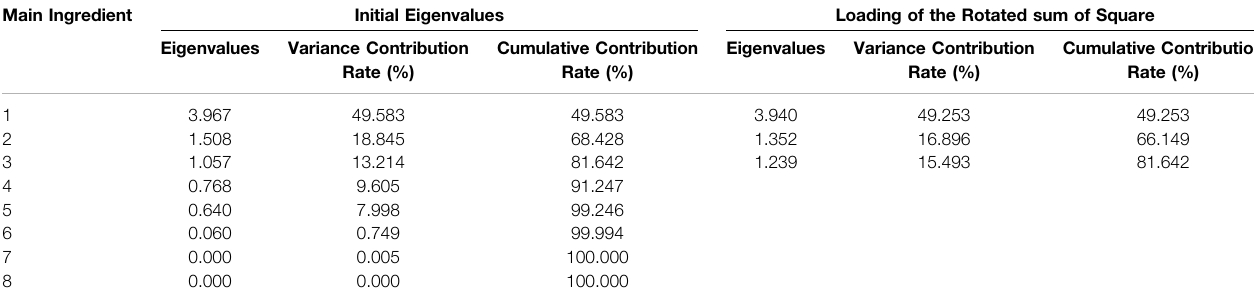
TABLE 3 | Results of principal component analysis. Main Ingredient